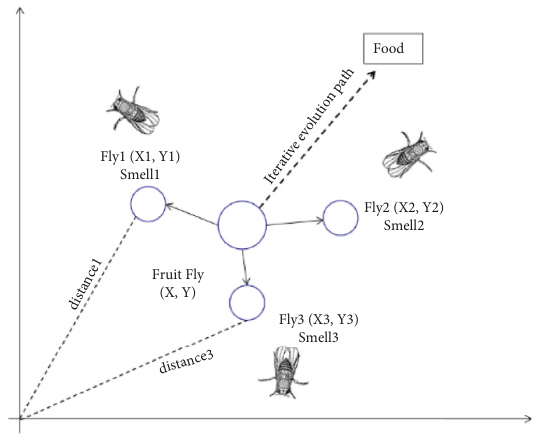
Figure 1: Fruit fly foraging